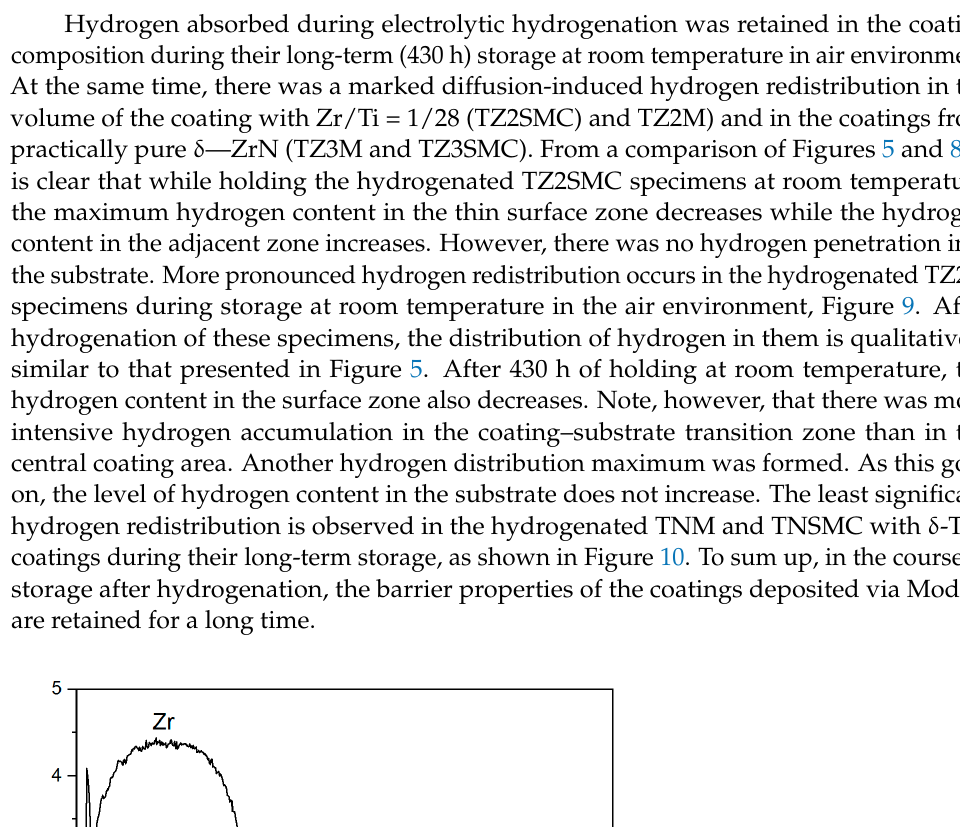
Figure 7. Thickness of the coatings formed on the Ti0.16Pd alloy versus the content of Zr in (Ti,Zr)N ( ● —from element distribution profiles; ○ —from TEM data).